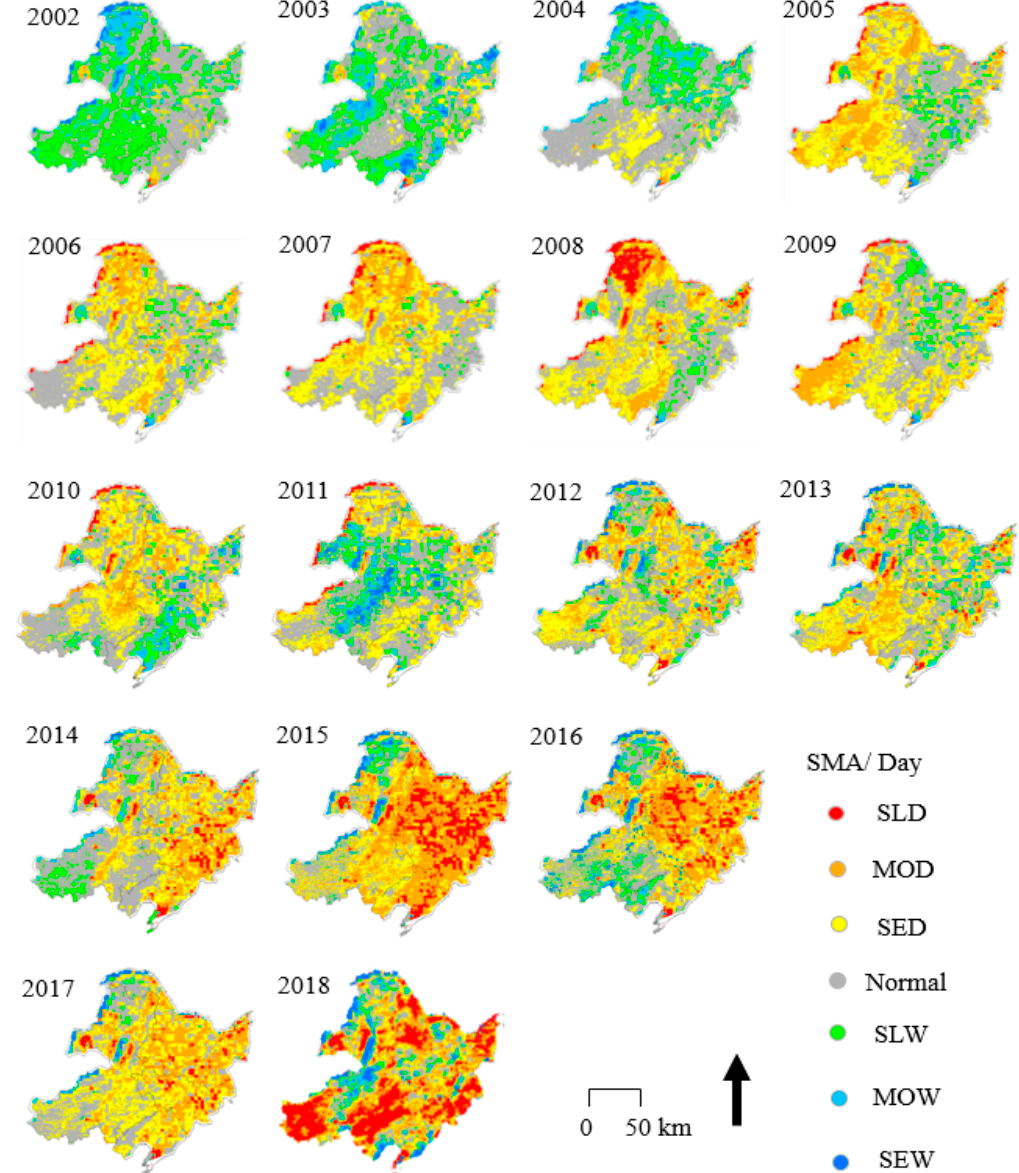
Figure 10. Spatial distribution of daytime soil moisture anomaly (SMA) in NEC from 2002 to 2018.